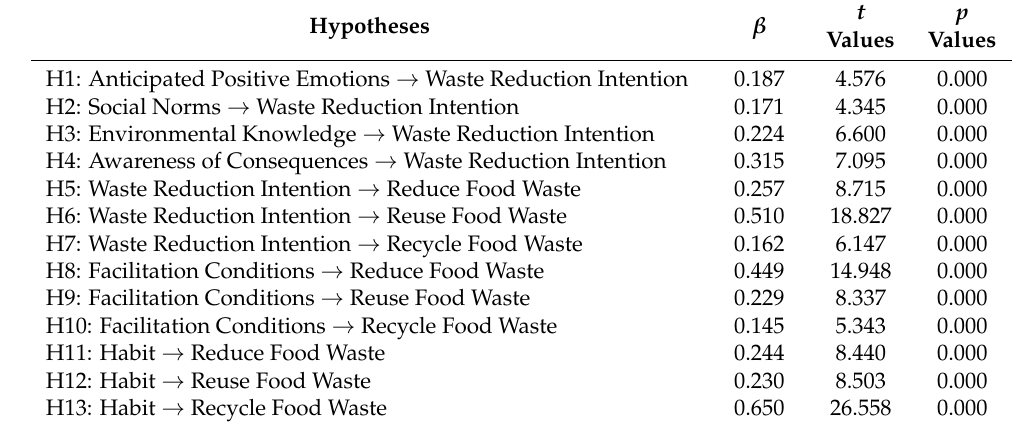
Table 4. Hypotheses